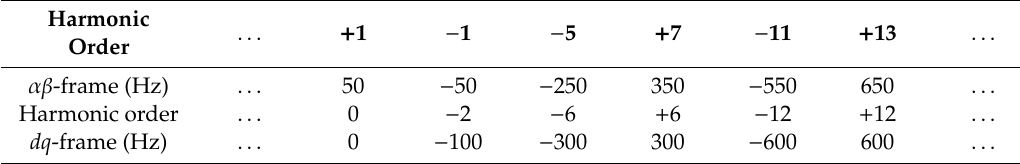
Table 1. Voltage sequence components in grid